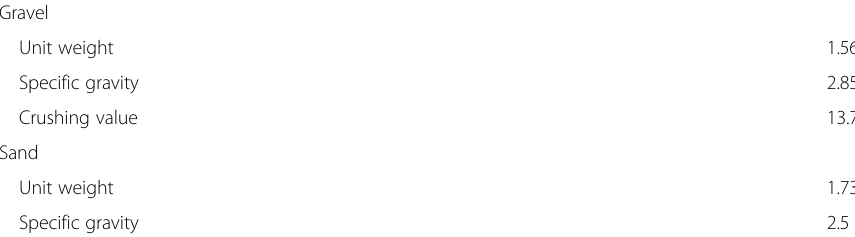
Table 2 Main physical and mechanical properties of the used gravel and sand Gravel